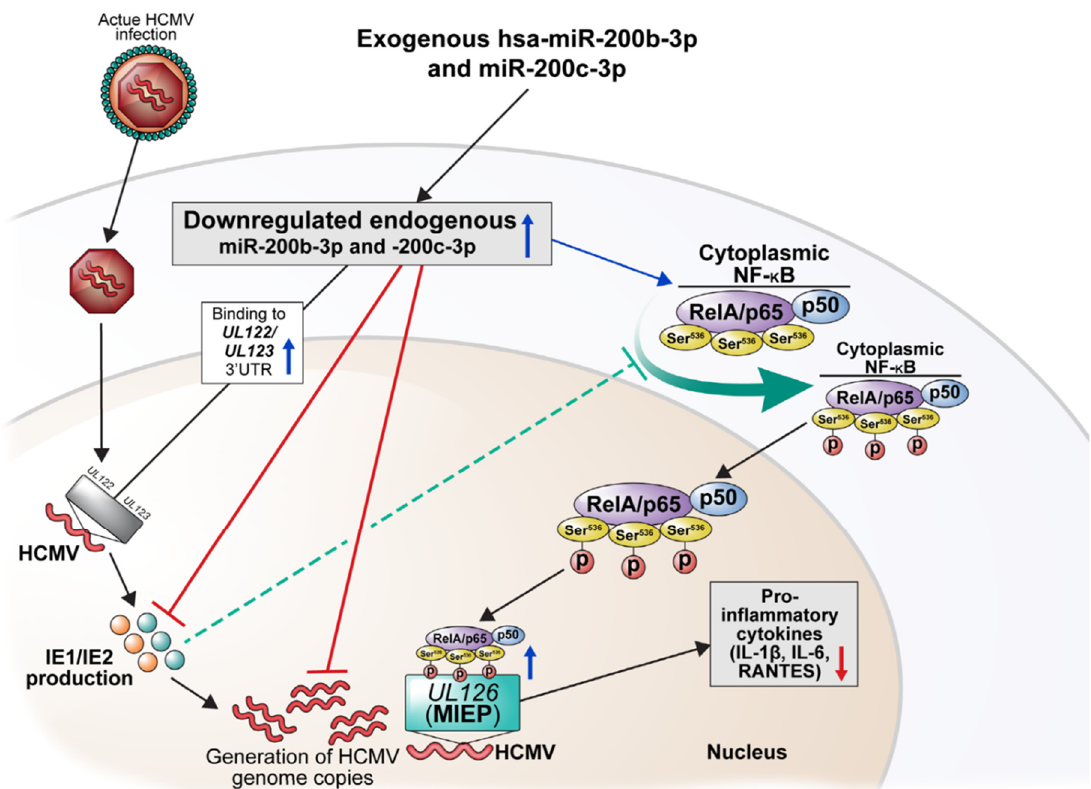
Figure 8. Schematic illustration of the potential benefits of exogenous miR ‐ 200b ‐ 3p and miR ‐ 200c ‐ 3p in acute lytic HCMV infection. Blue and red arrows or lines indicate the enhancing and inhibitory effects of exogenous miR ‐ 200b ‐ 3p and miR ‐ 200c ‐ 3p, respectively. Green dashed line indicates the direct suppression by IE proteins.